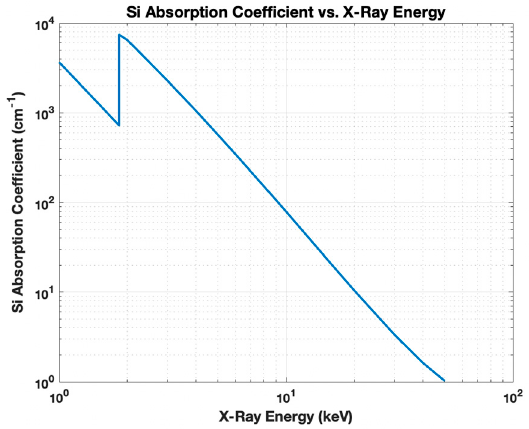
Figure 1. The absorption coefficient of Si vs. X-ray energy for 1–50 keV computed using the NIST database for Si [2].